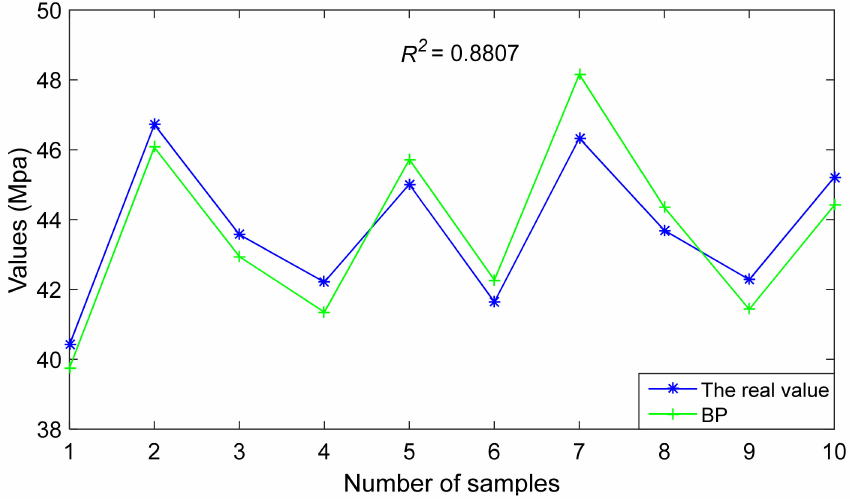
Figure 3. Comparison of the first roof weighting